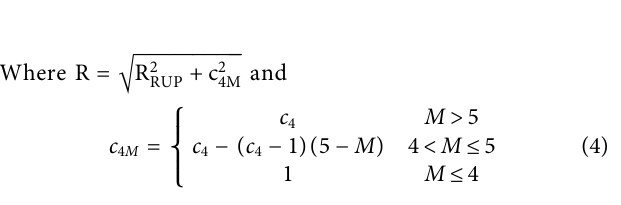
Frontiers in Earth Science |